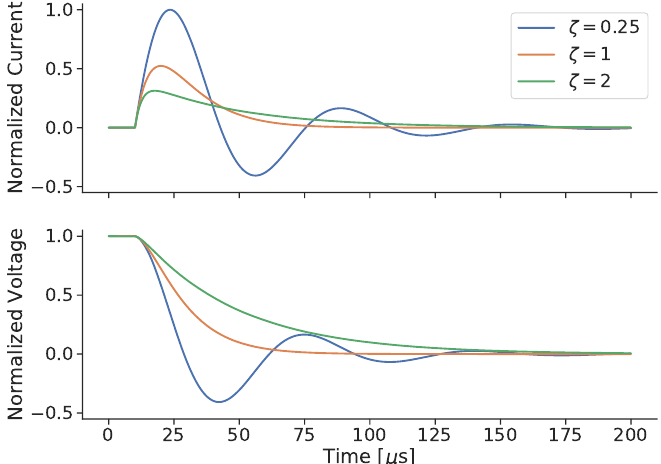
Figure 23. Simulated underdamped, critically damped, and overdamped RLC discharge circuit waveforms for the capacitor voltage and